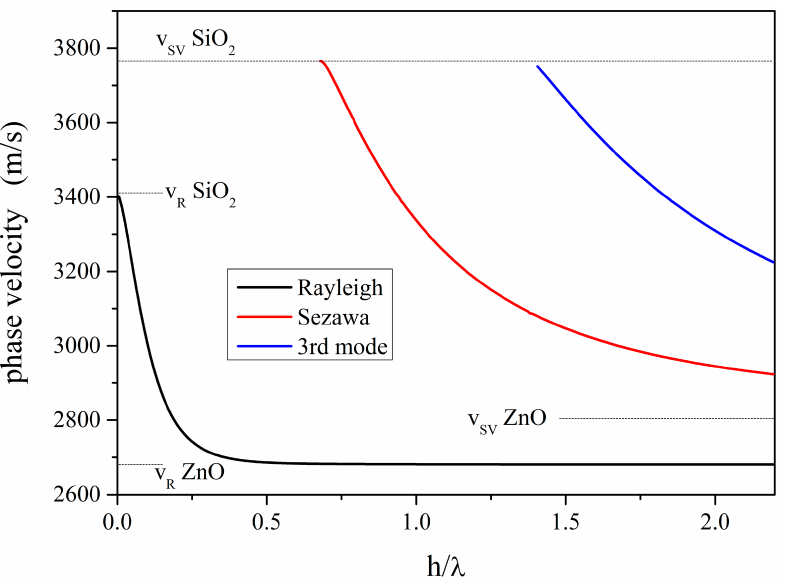
Figure 1. The phase velocity dispersion curves of the Rayleigh waves in the multi-mode SiO 2 /ZnO structure.